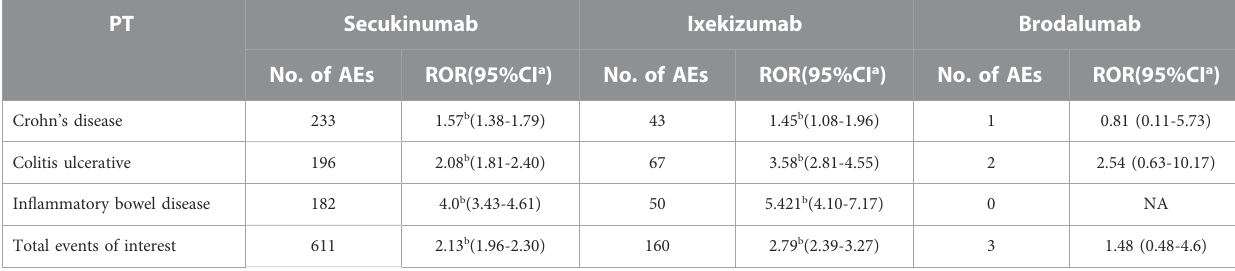
TABLE 2 Interleukin -17 inhibitors associated with In fl ammatory bowel disease and the reporting odds ratios in FAERS